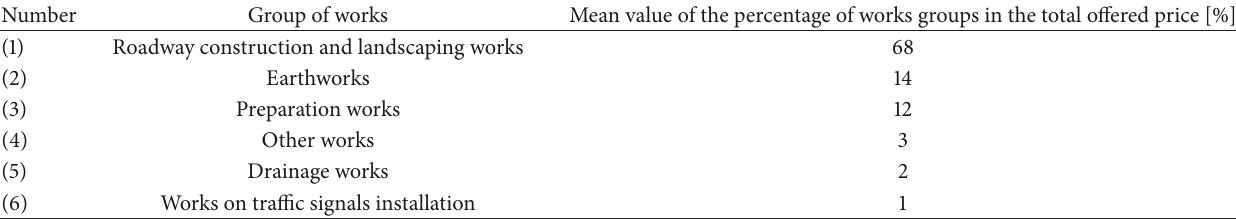
Table 1: Mean values of the percentage of works groups in the total offered value.